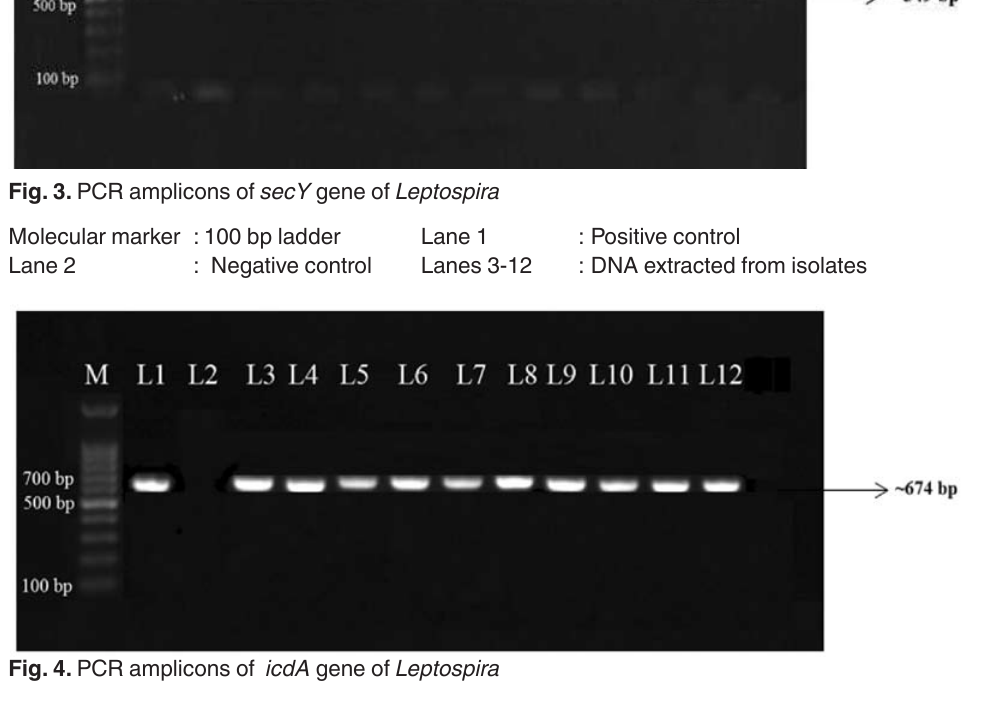
Fig. 4. PCR amplicons of icdA gene of